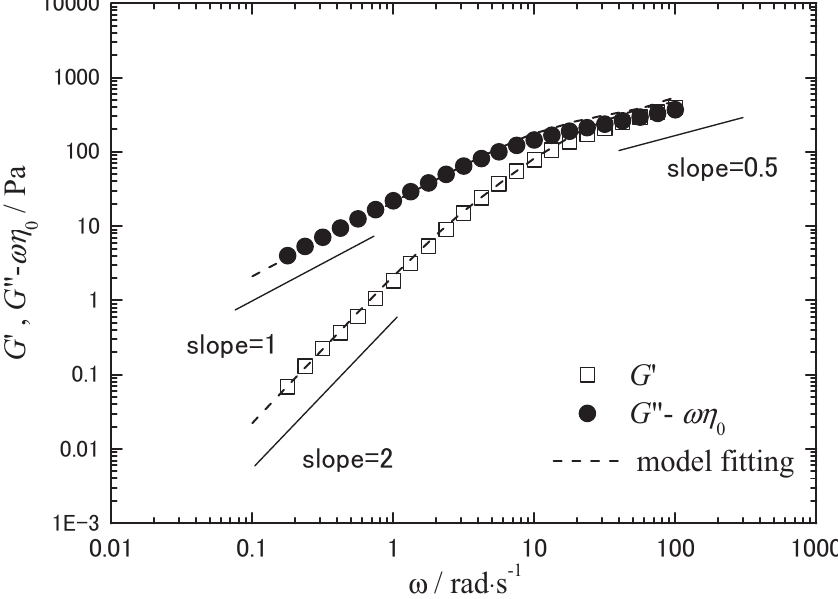
Figure 13. Viscoelastic measurement results on BMIMCl solution of a standard pullulan (MW = 4.04 × 10 5 , MWD =1.13). G ', G ", and (cid:9) are storage modulus, loss modulus and angular frequency, respectively. C = 4.0 × 10 (cid:10)2 (g/cm 3 ), T = 25 °C. The broken lines